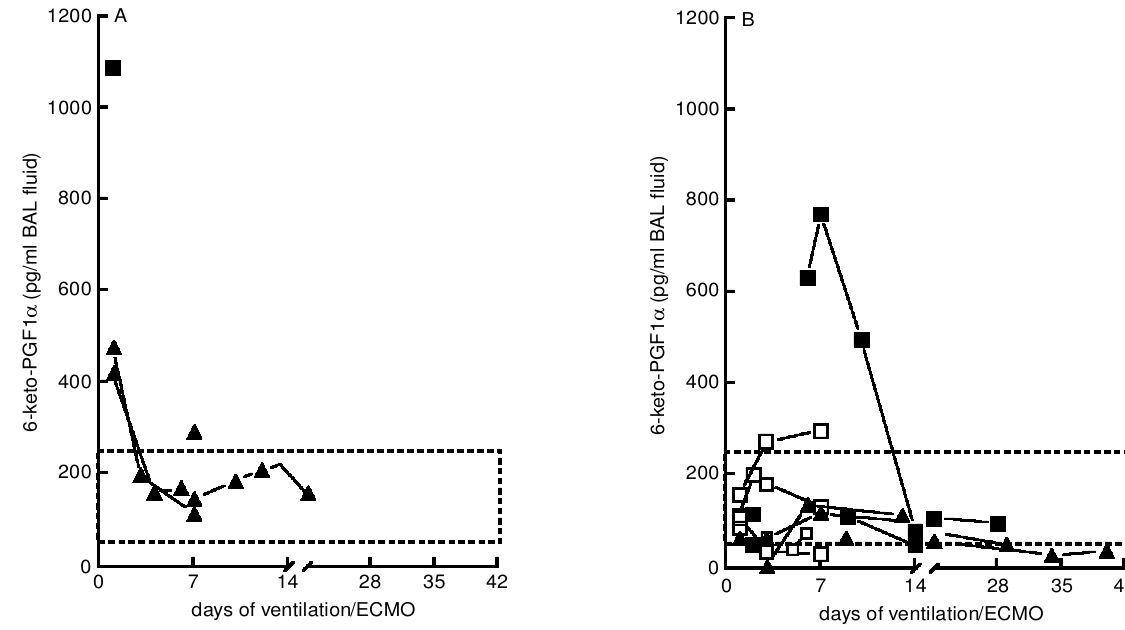
FIG. 1. The concentrations of 6-keto-PGF 1 a in BAL ¯ uid of non-surviving CDH patients (A) and CDH survivors (B) are shown. Conventionally ventilated patients, j , u ; ECMO-treated patients, n , m . Closed symbols represent a poor clinical outcome: death (A) or O 2 -dependency at 28 days (B). Each measurement is indicated by an individual symbol, a line through the symbols indicates that more BAL procedures were performed on one patient. The box represents the interquartile range concentration of 6-keto-PGF 1 a during the ® rst 2 days of ventilation in 10 control patients without PPH.